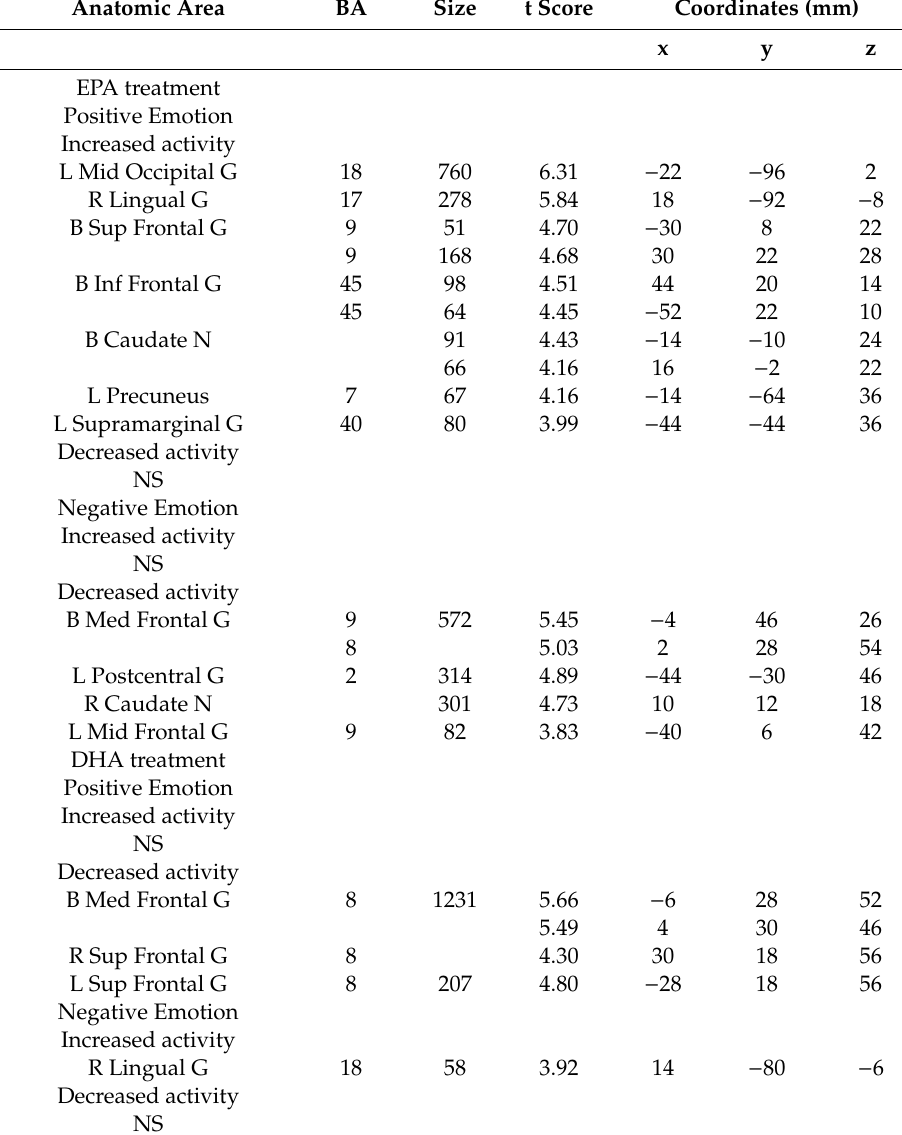
Table 2. The changes in brain response to di ff erent emotion stimuli after eicosapentaenoic acid or docosahexaenoic acid